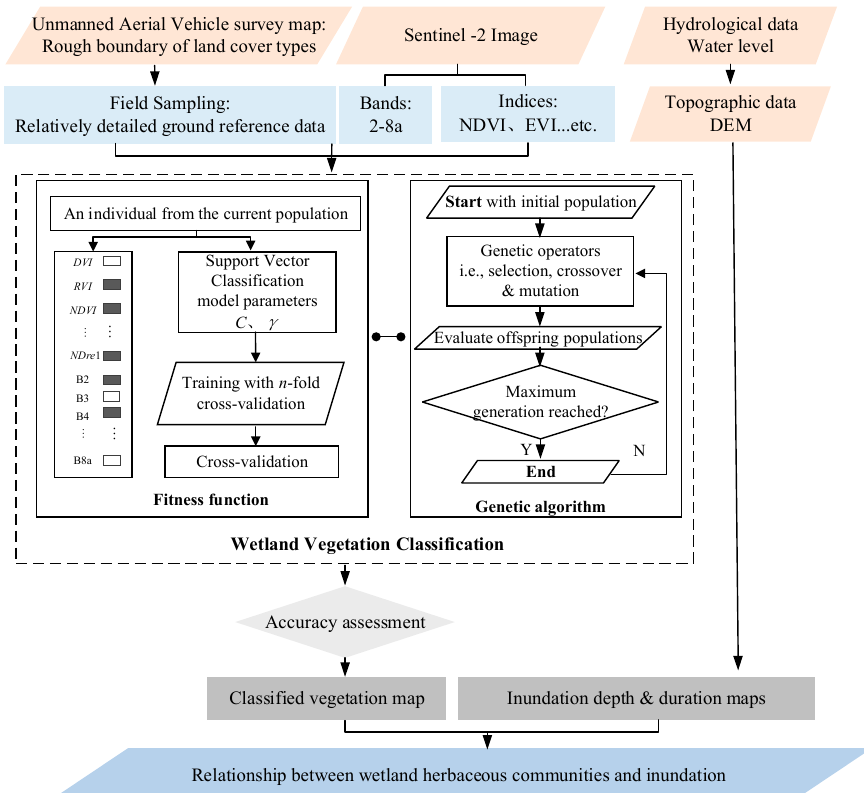
Figure 2. A flowchart of the integrated analytical framework of hydrological driving factors of the spatial distribution of wetland herbaceous communities. NDVI, EVI, DVI, RVI, and NDre1 are vegetation indices (Table A1). The dashed box represents the synchronous optimization process of input variables and support-vector classification parameters based on a genetic algorithm. Gray blocks indicate the potentially selected parameters.